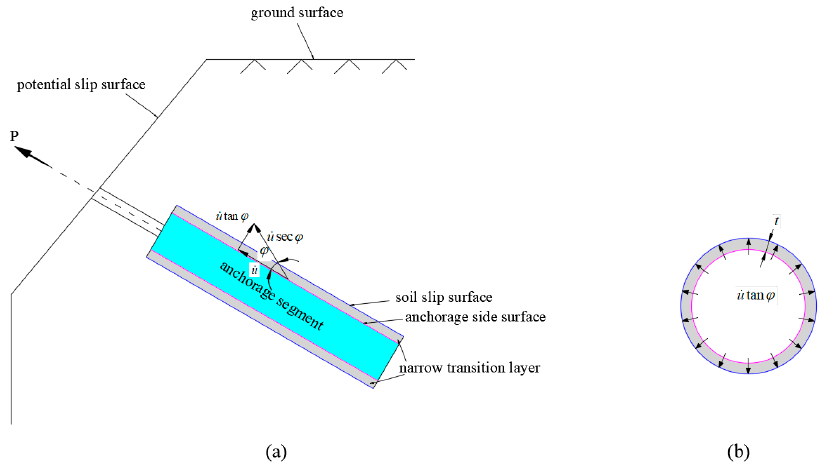
Figure 7. The velocity field of the anchorage segment region: ( a ) profile diagram, ( b ) cross-sectional diagram.